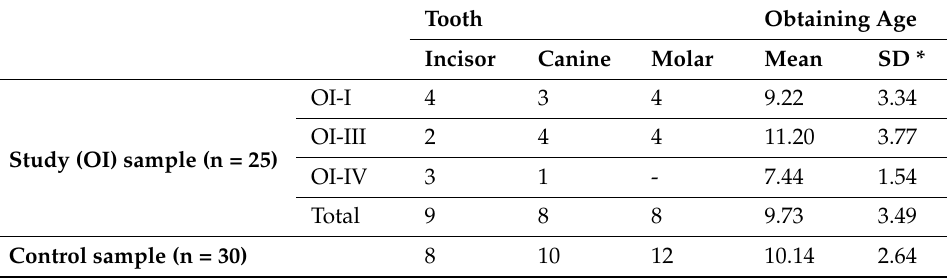
Table 3. Demographic description of the study